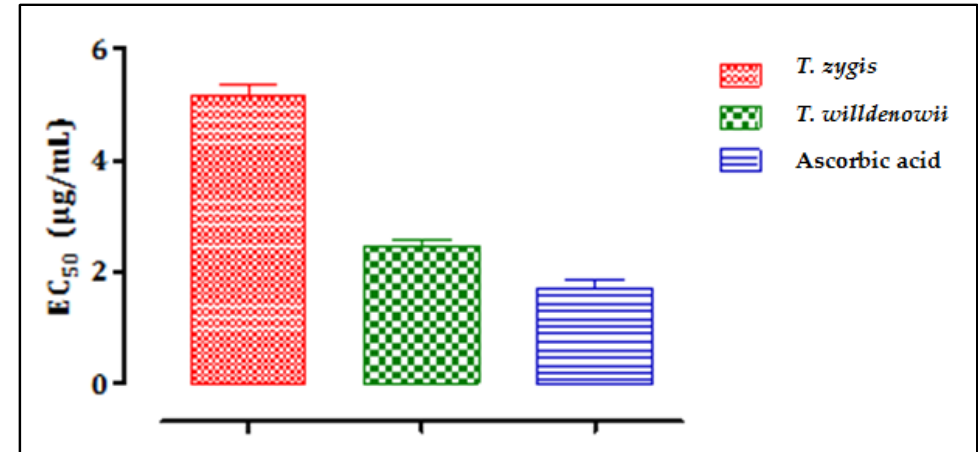
Figure 4. The effective concentrations (EC 50 ) of T. zygis , T. willdenowii and ascorbic acid; data are mean ± SD, experiment was performed in minimum 2 replicates T. zygis : Thymus zygis , T. willdenowii : Thymus willdenowii.